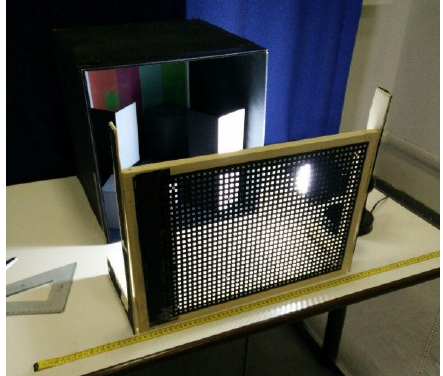
Figure 3. Structure and grid used in